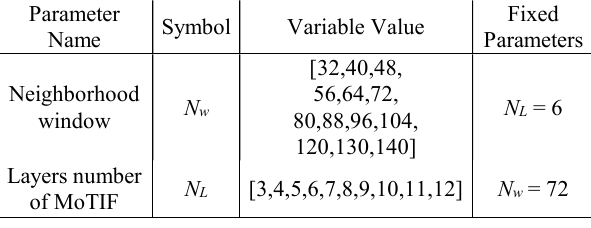
Table 2 . Matching parameters configuration.